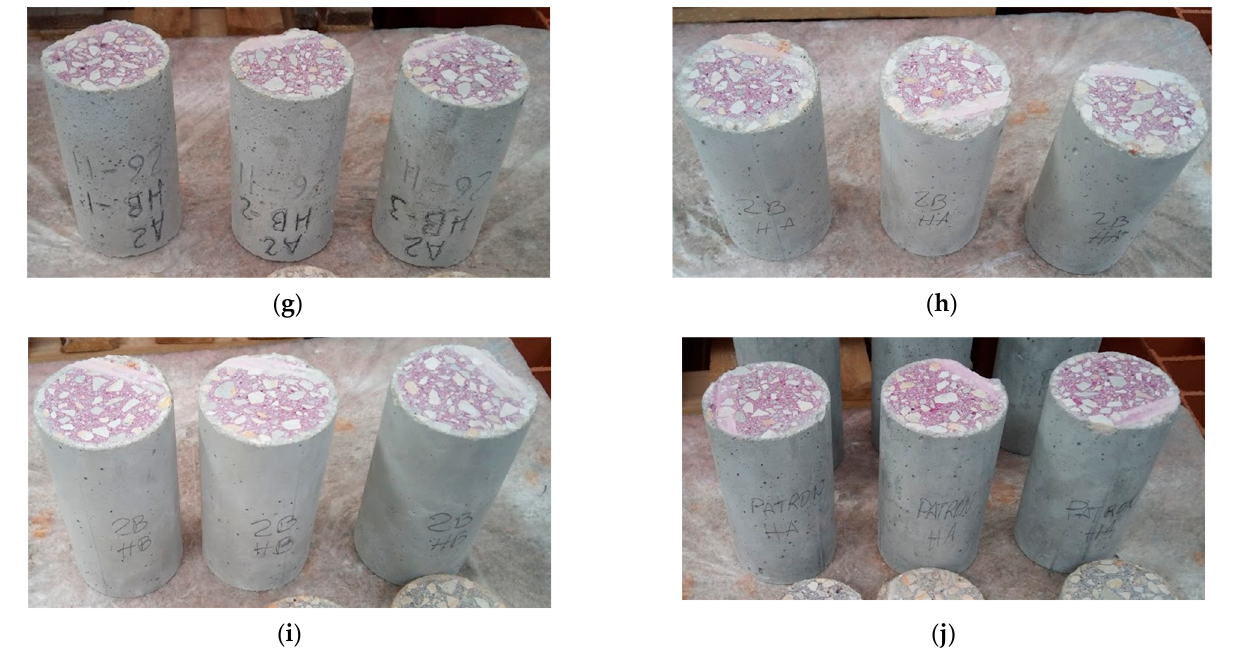
Figure 3. Carbonation depth results obtained for concretes A and B measured in three concrete samples: ( a ) A-SA25VA25; ( b ) B-SA25VA25; ( c ) A-SB25VA25; ( d ) B-SB25VA25; ( e ) A-SA40VA25; ( f ) B-SA40VA25; ( g ) B-SB40VA25; ( h ) B-SB40VA25; ( i ) reference concrete A; ( j ) reference concrete B.